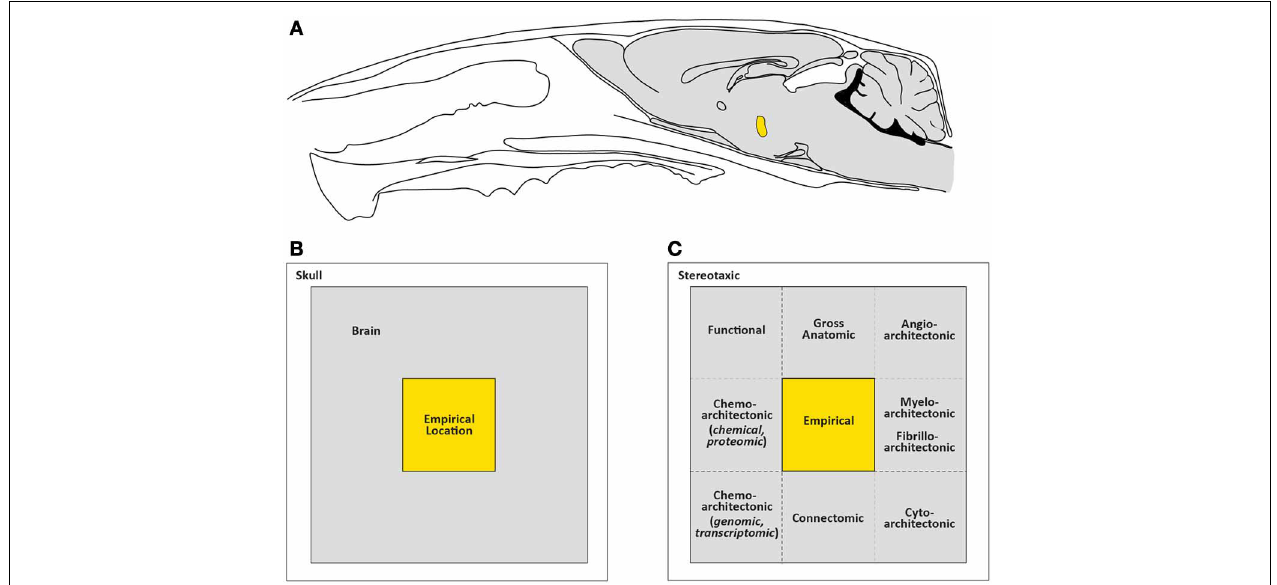
FIGURE 4 | A conceptual framework for organizing thoughts concerning injection site localization. (A) Outline of a rat skull (black outline only), rat brain (gray), and injection site (gold); showing the topological relations of these three spaces. The drawing is adapted from König and Klippel (1963). (B) The topological relations shown in (A) are simplified in a nested square arrangement here. Note the names given to each space. (C) A conversion of the relationships presented in (B) within the context of methodologically visualizable spaces. Stereotaxic